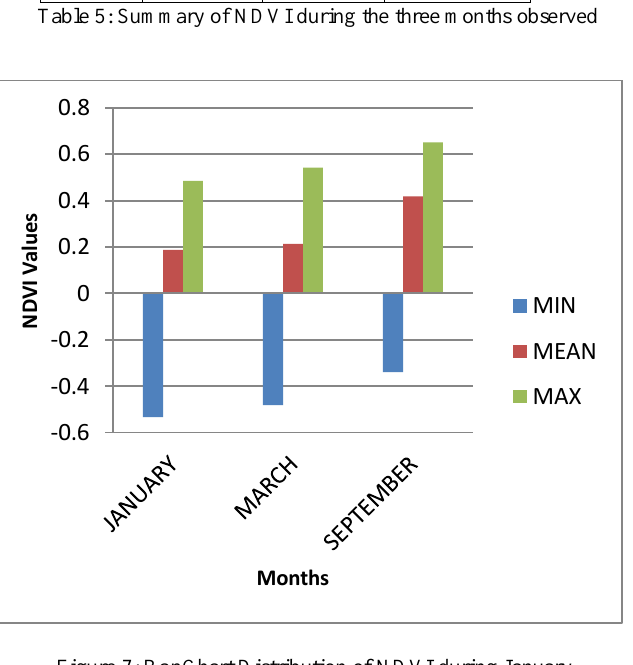
Figure 7: Bar Chart Distribution of NDVI during January, March and September 2013.